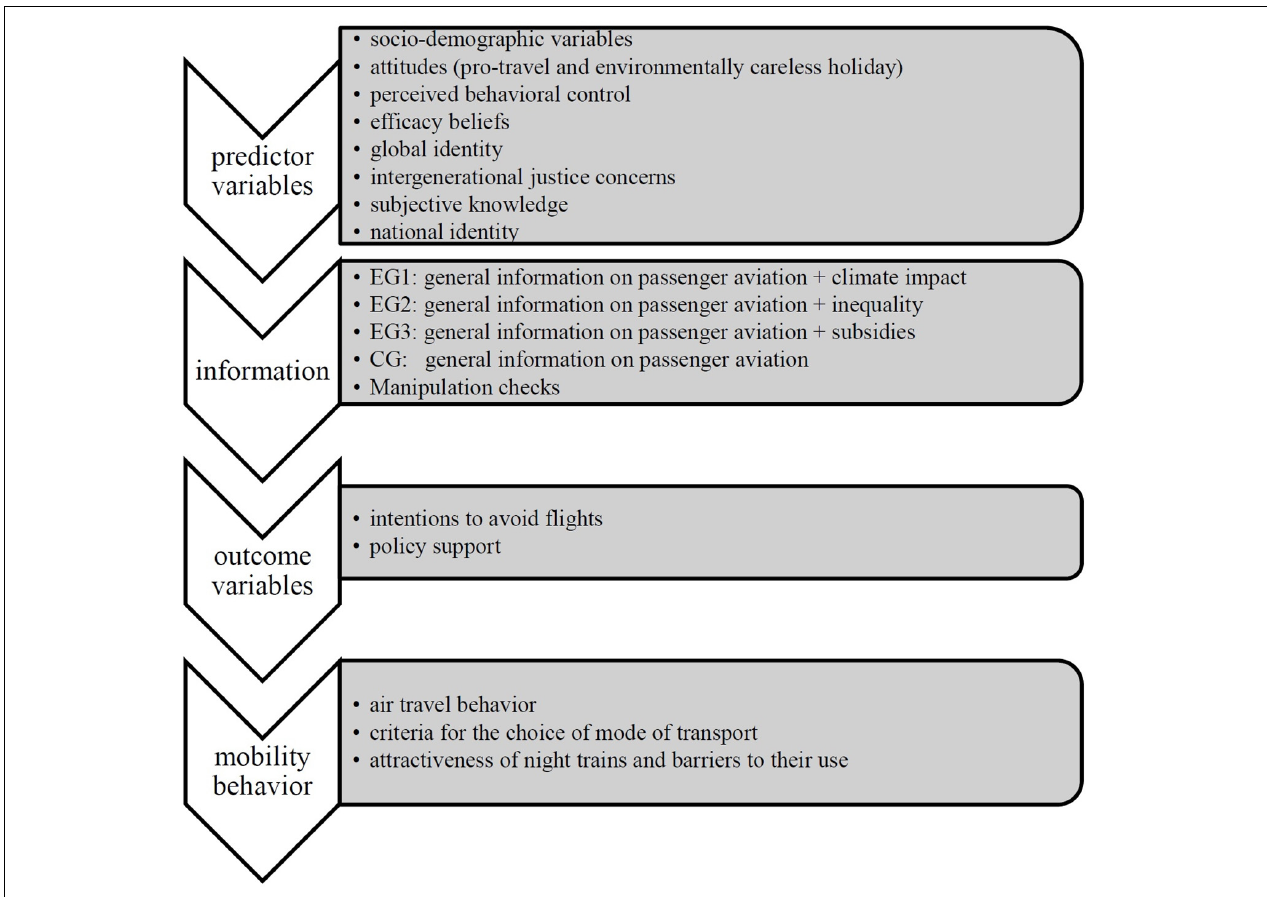
FIGURE 1 | Survey